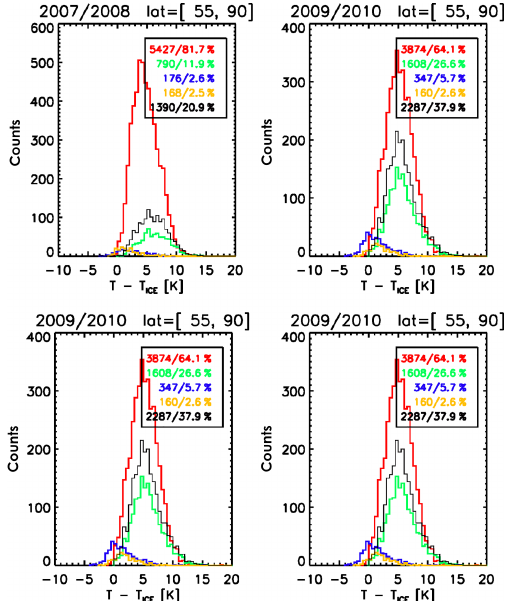
Figure 4. The 4 years of NH polar winter PSC type frequency dis- tributions with respect to T ICE (2007/2008, 2009/2010, 2010/2011, and 2011/2012) using the analogue presentation of Fig. 3. Please note the changing scale of observation counts for each